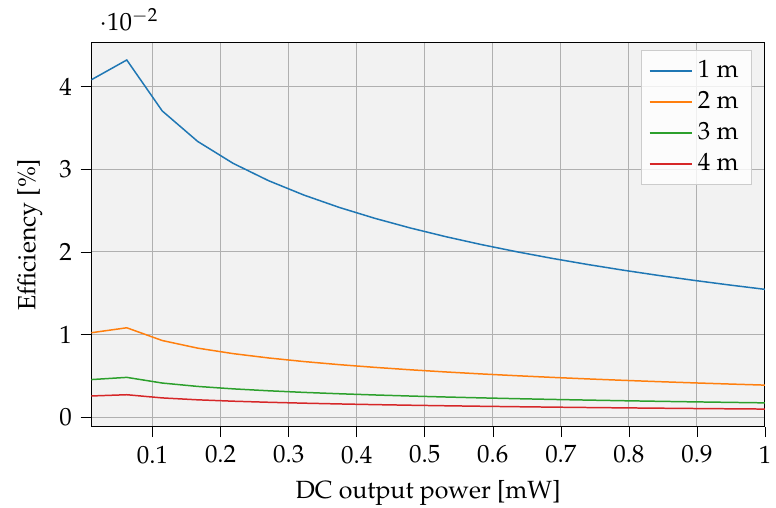
Figure 15. Estimate of the achievable efficiency levels for a SISO RFPT system with a PA with 77% efficiency. The maximum EIRP limit of 38.15dbm is not taken into